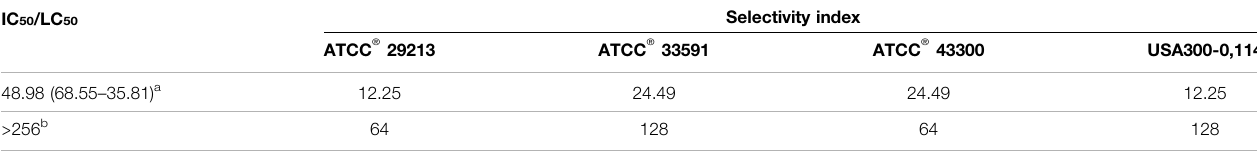
TABLE 3 | Cytotoxicity of FD-I-34S on MRC-5 cells and selective indexes against S. aureus